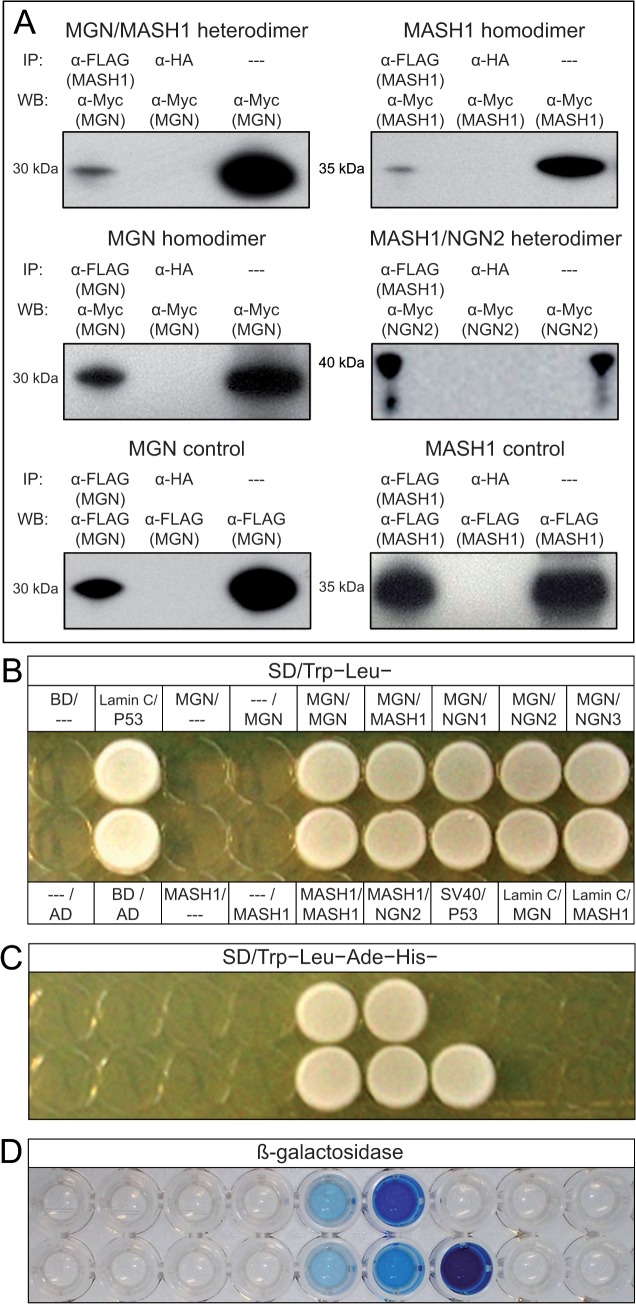
MGN formed homodimers and heterodimers with MASH1 in yeast.
(A) HEK293 cells were co-transfected, immunoprecipitated (IP), and analyzed by western blotting (WB) with plasmids and antibodies indicated in the IP and WB lines, respectively. The amounts of MGN, MASH1, and NGN2 were verified in total cell lysates (—-) as a control test. Anti-HA antibody (α-HA) was used as a negative control. (B) Y2H analysis of the interactions between MGN and different proneural proteins. AH109 yeasts were co-transformed with a bait and prey plasmid (bait/prey) before being plated on synthetic dropout medium (SD/Leu−Trp−). (C) The same yeast colonies were plated in the same order on SD/Ade−His−Leu−Trp− (to select positive protein–protein interactions) and used for the ß-galactosidase activity assay (D). Binding domain (BD) alone and activator domain (AD) alone plasmids; BD–human Lamin C provided a control for the AD–prey interaction. P53/SV40 interaction was used as positive control (P53/SV40 was diluted to 1 in 5 in D).